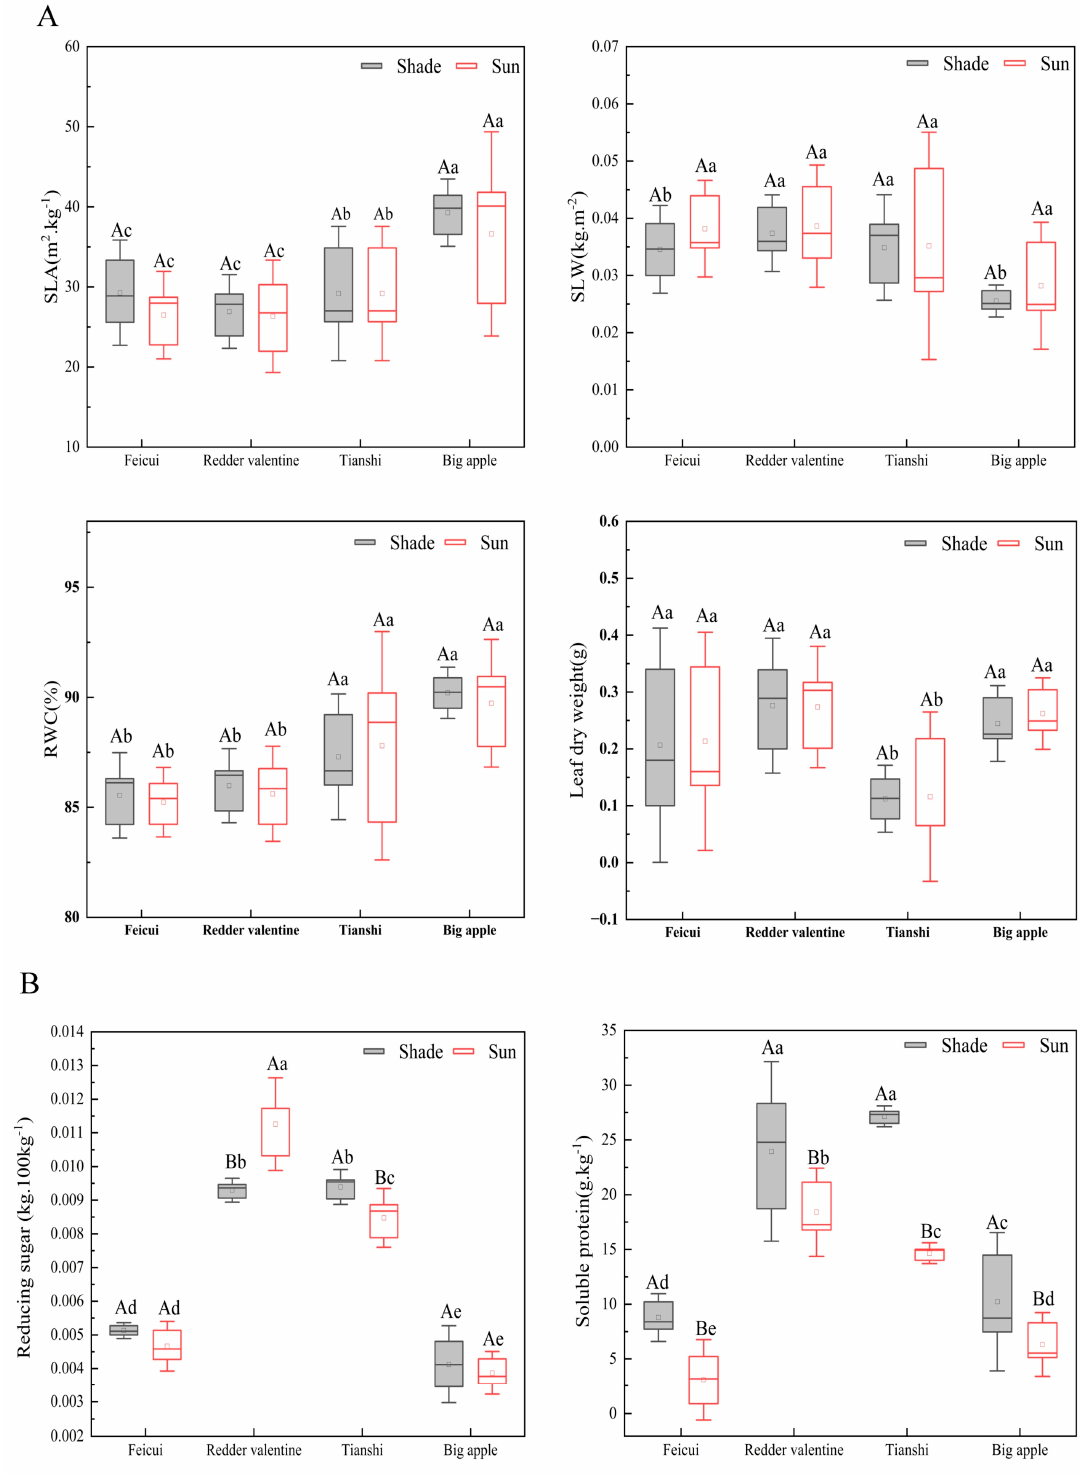
Figure 2. Physiological and biochemical indexes in shade and sun of four A. commutatum cultivars. ( A ) Changes in specific leaf area (SLA), specific leaf weight (SLW), water content (RWC), and leaf dry weight. ( B ) Changes in soluble protein and reducing sugar content. Different lowercase letters in the same column represent significant differences between cultivars, and different capital letters represent significant differences within the same cultivar ( p < 0.05, Duncan’s multiple range test).